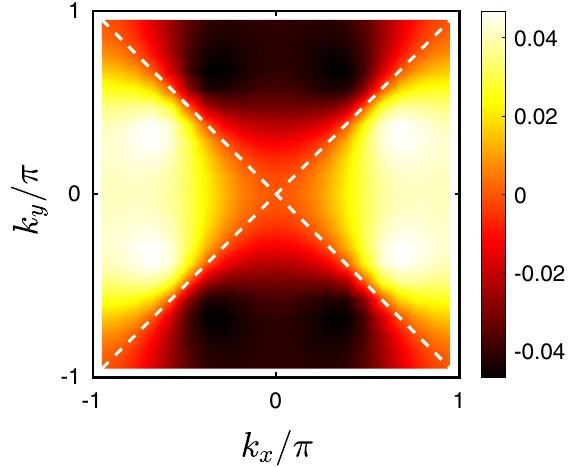
FIG. 3. The d -wave symmetry of the Cooper pair component in the two-hole ground state j Ψ − i 2 , as shown by the overlap Δ s h k defined in Eq. (16) on a 20 × 20 lattice. The dashed (white) lines denote the nodal lines with the sign change across